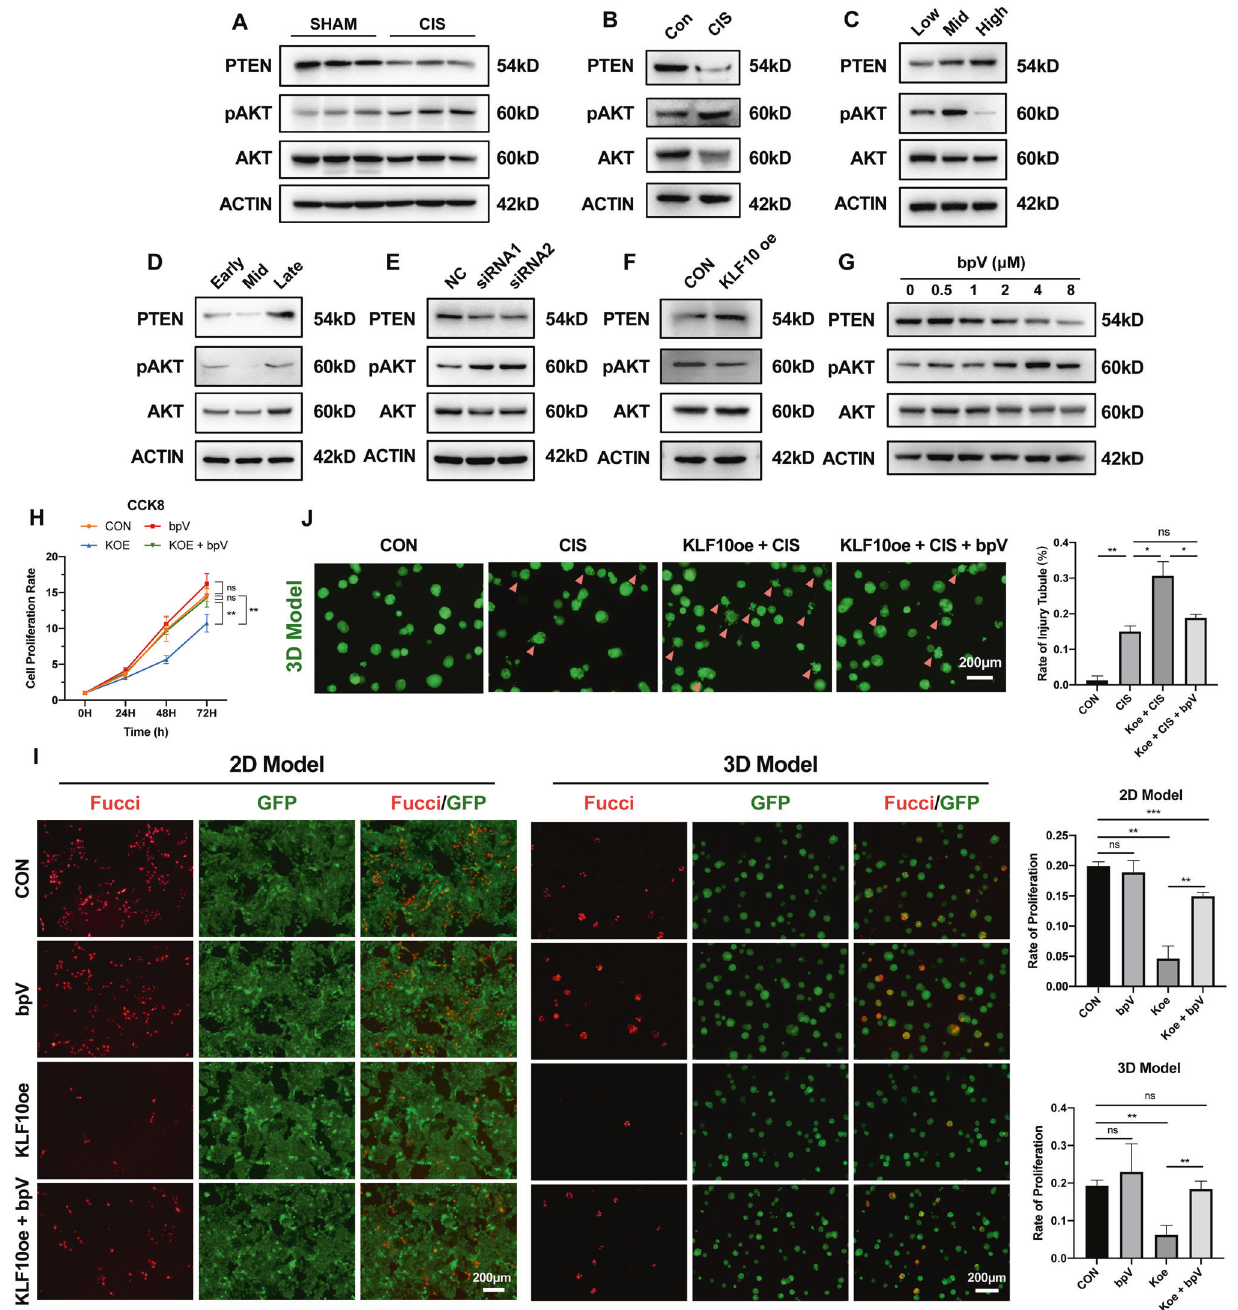
Fig. 7 KLF10 inhibited tubular regeneration via PTEN/AKT pathway. A Representative immunoblot analysis of PTEN, pAKT and AKT in cisplatin-induced AKI group and control group. ACTIN served as the standard. n = 6 per group. B Representative immunoblot analysis of PTEN, pAKT and AKT in 3D AKI group and control group. ACTIN served as the standard. C Representative immunoblot analysis of PTEN, pAKT and AKT in low-/middle-/high-density group. ACTIN served as the standard. D Representative immunoblot analysis of PTEN, pAKT and AKT in early/ middle/late stages of tubular formation in 3D renal tubular model. ACTIN served as the standard. E Representative immunoblot analysis of PTEN, pAKT and AKT in siRNA transfected group and control group. ACTIN served as the standard. F Representative immunoblot analysis of PTEN, pAKT and AKT in KLF10 overexpressed group and control group. ACTIN served as the standard. G Representative immunoblot analysis of PTEN, pAKT and AKT in bpV treatment group with different concentration. ACTIN served as the standard. H The cell viability in bpV (4 μ M) treated/KLF10 overexpression/bpV (4 μ M) treated + KLF10 overexpression group and control group were measured by CCK-8 assay. I Representative fl uorescence image of Fucci in bpV (4 μ M) treated/ KLF10 overexpression/ bpV (4 μ M) treated + KLF10 overexpression group and control group (2D/3D cultured). J Representative image of 3D renal tubular model in cisplatin (75 μ M) treated/cisplatin (75 μ M) treated + KLF10 overexpression/cisplatin (75 μ M) treated + KLF10 overexpression + bpV (4 μ M) treated group and control group. ns p ≥ 0.05, * p < 0.05, ** p < 0.01, *** p < 0.001 vs control group at the same experimental